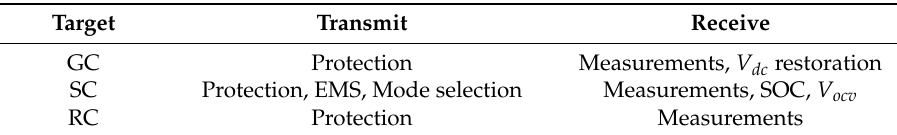
Table 2. Communication of the central controller. SOC: state of charge.